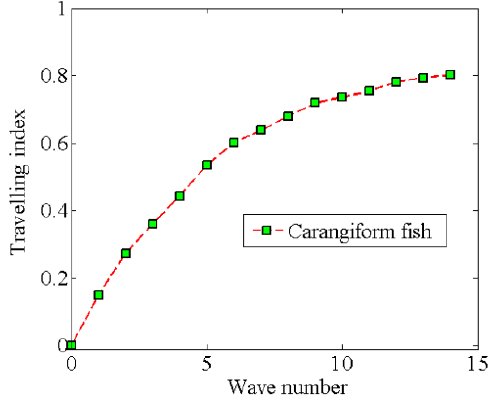
Figure 10. The changing pattern of travelling index along with the wave number.